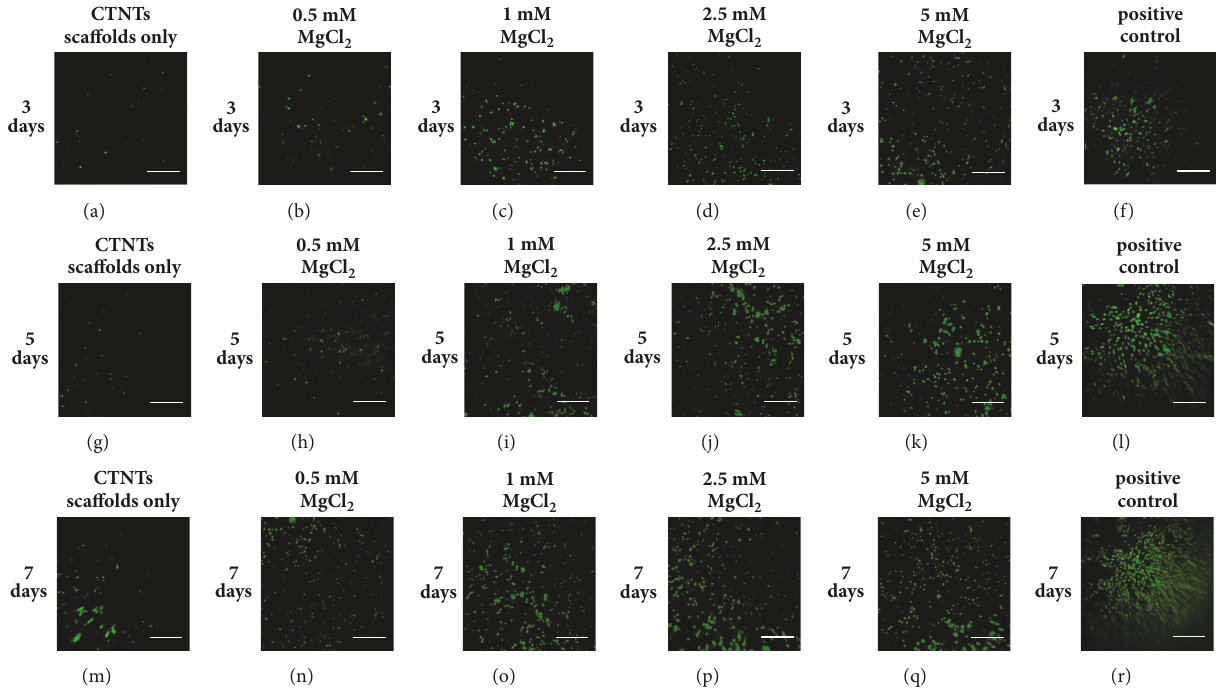
Figure 6: FDA-stained MG63 cells cultured on CTNTs scaffolds only and with Mg 2+ ions adsorbed at different initial concentrations of MgCl 2 for 3 (a-f), 5 (g-l), and 7 (m-r) days. Scaffolds and polystyrene well (positive control) were seeded with approximately 30,000 cells/well in 24-well plates. Scale bar corresponds to 100 𝜇 m.